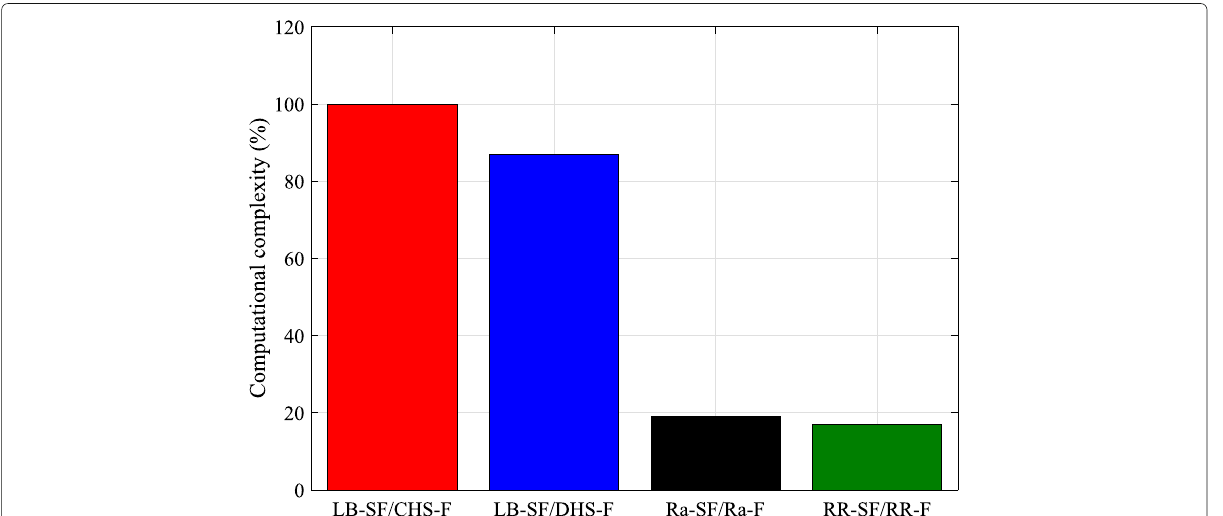
Fig. 12 Relative computational complexities. Average computational complexities of each algorithm needed for convergence at each scheduling period relative to algorithm